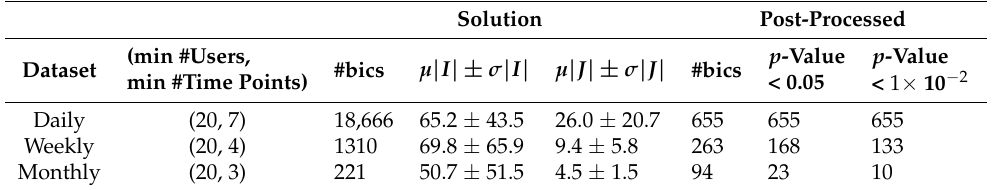
Table 2. Properties of the biclustering solutions found assuming constant patterns at InfraQuinta, 2017. Solution Post-Processed